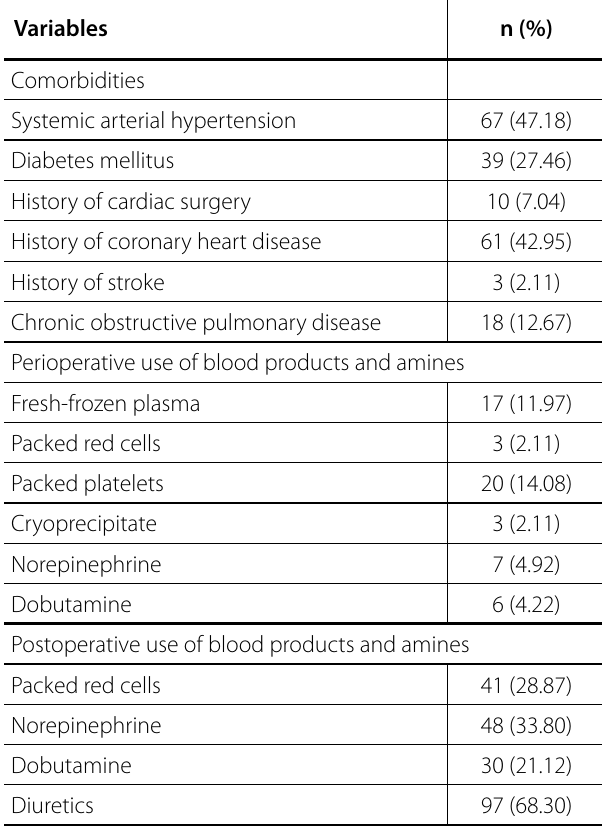
Table 1 . Descriptive analysis of the preoperative, perioperative, and postoperative variables studied in 142 patients undergoing cardiac